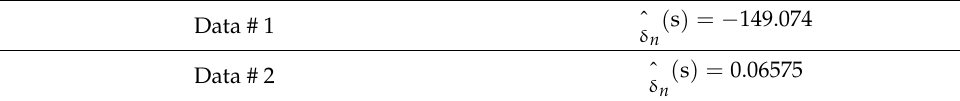
Table 4. Detailed statistics, for data